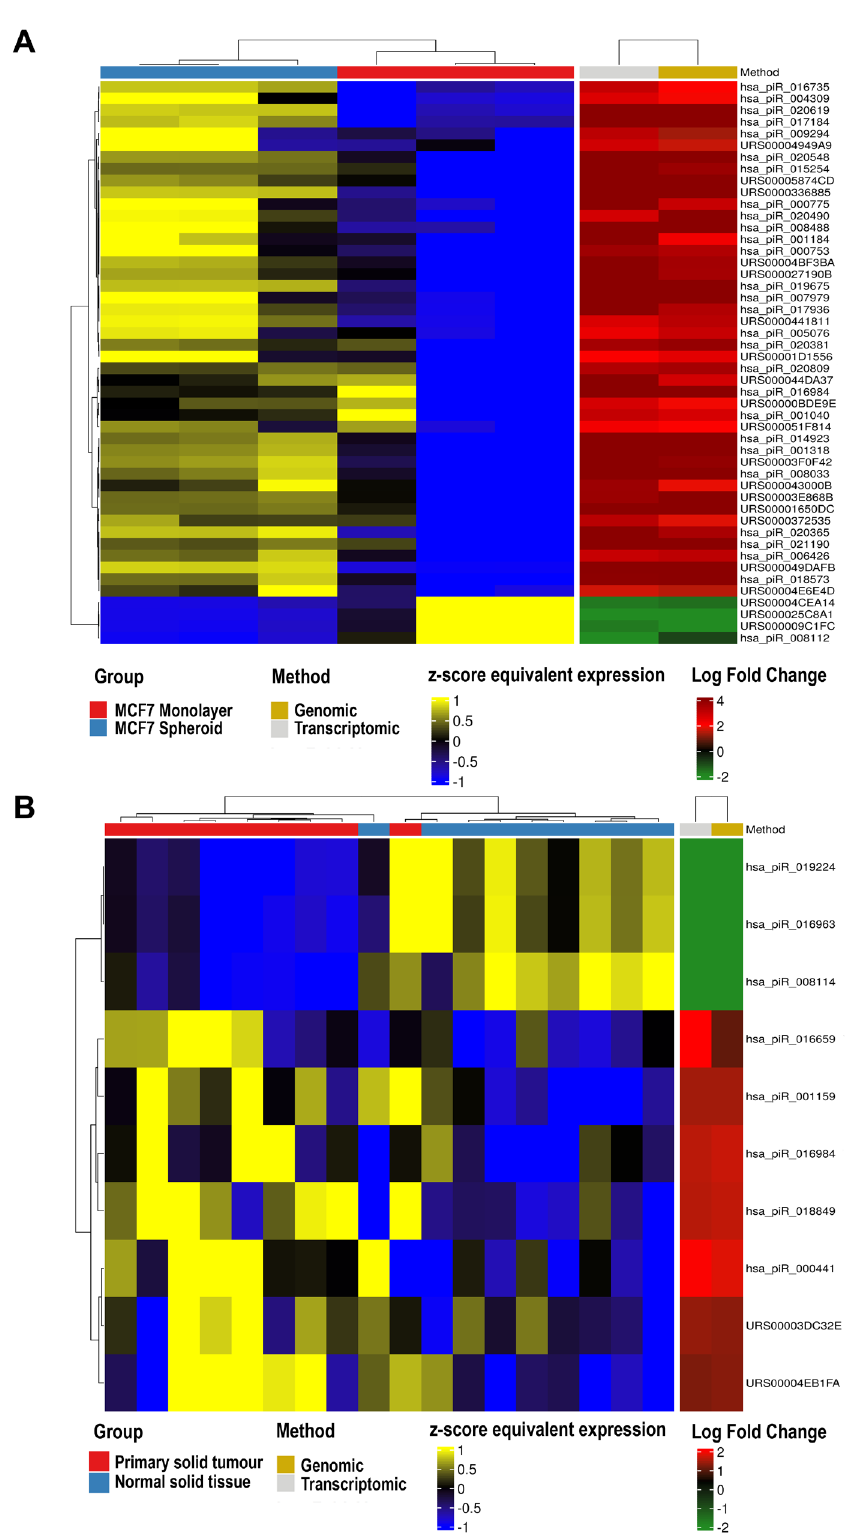
Figure 6. Differential expression analysis. A ) Heatmap of differentially expressed piRNAs in 3 MCF7 Spheroid samples versus 3 MCF7 Monolayer (GSE68246 public dataset) found in common with both approaches (genomic and transcriptomic). B ) Heatmap of differentially expressed piRNAs among 9 Primary Solid Tumour versus 9 Solid Tissue Normal from TCGA found in common with both approaches (genomic and transcriptomic).